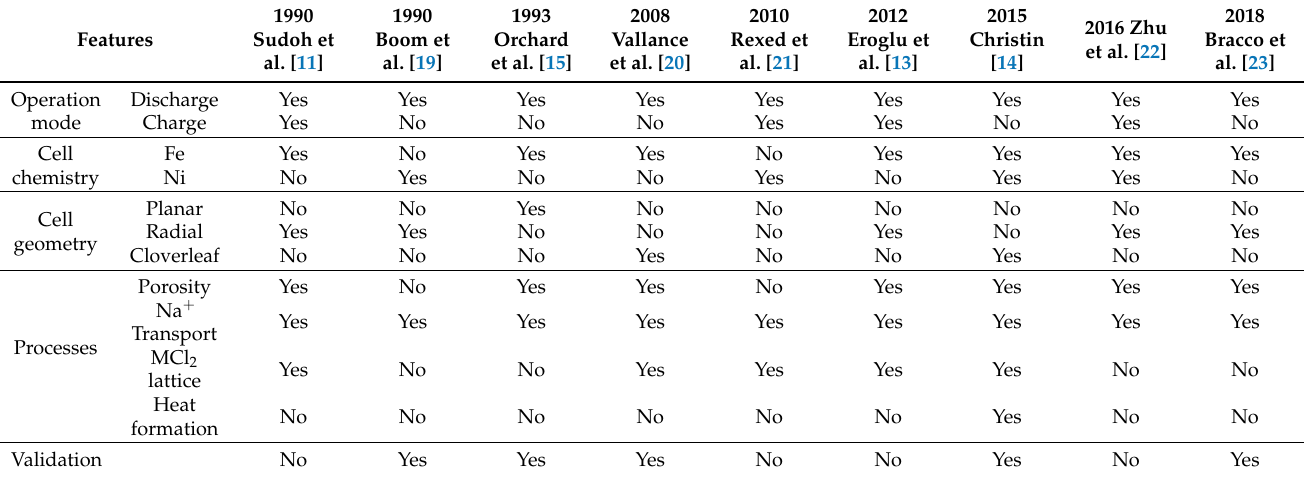
Table 1. Literature overview of Na-NiCl 2 and Na-FeCl 2 cell